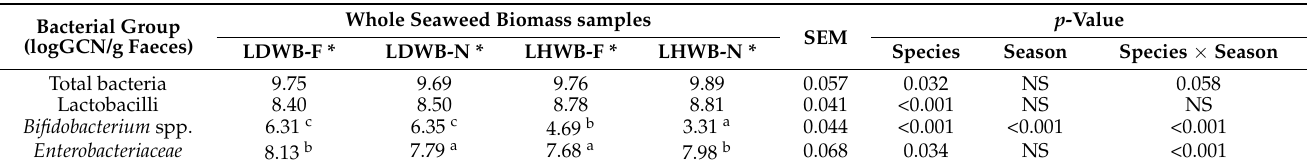
Table 5. Effects of seaweed species and harvest season on the selected bacterial populations of the faecal microbiota in the batch fermentation assay (least-square means and standard error of the